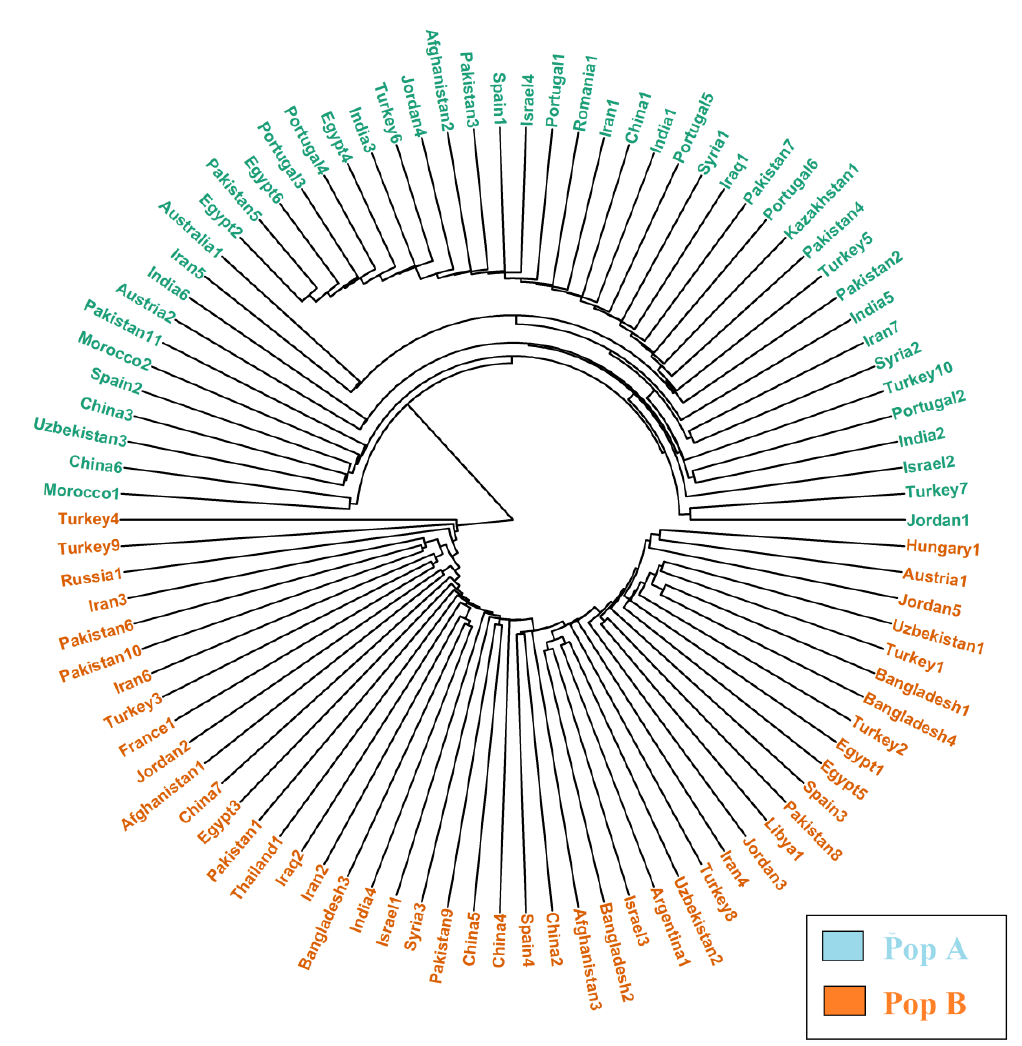
Figure 7. Neighbor joining-based clustering of the 94 safflower accessions using silicoDArT molecular markers.